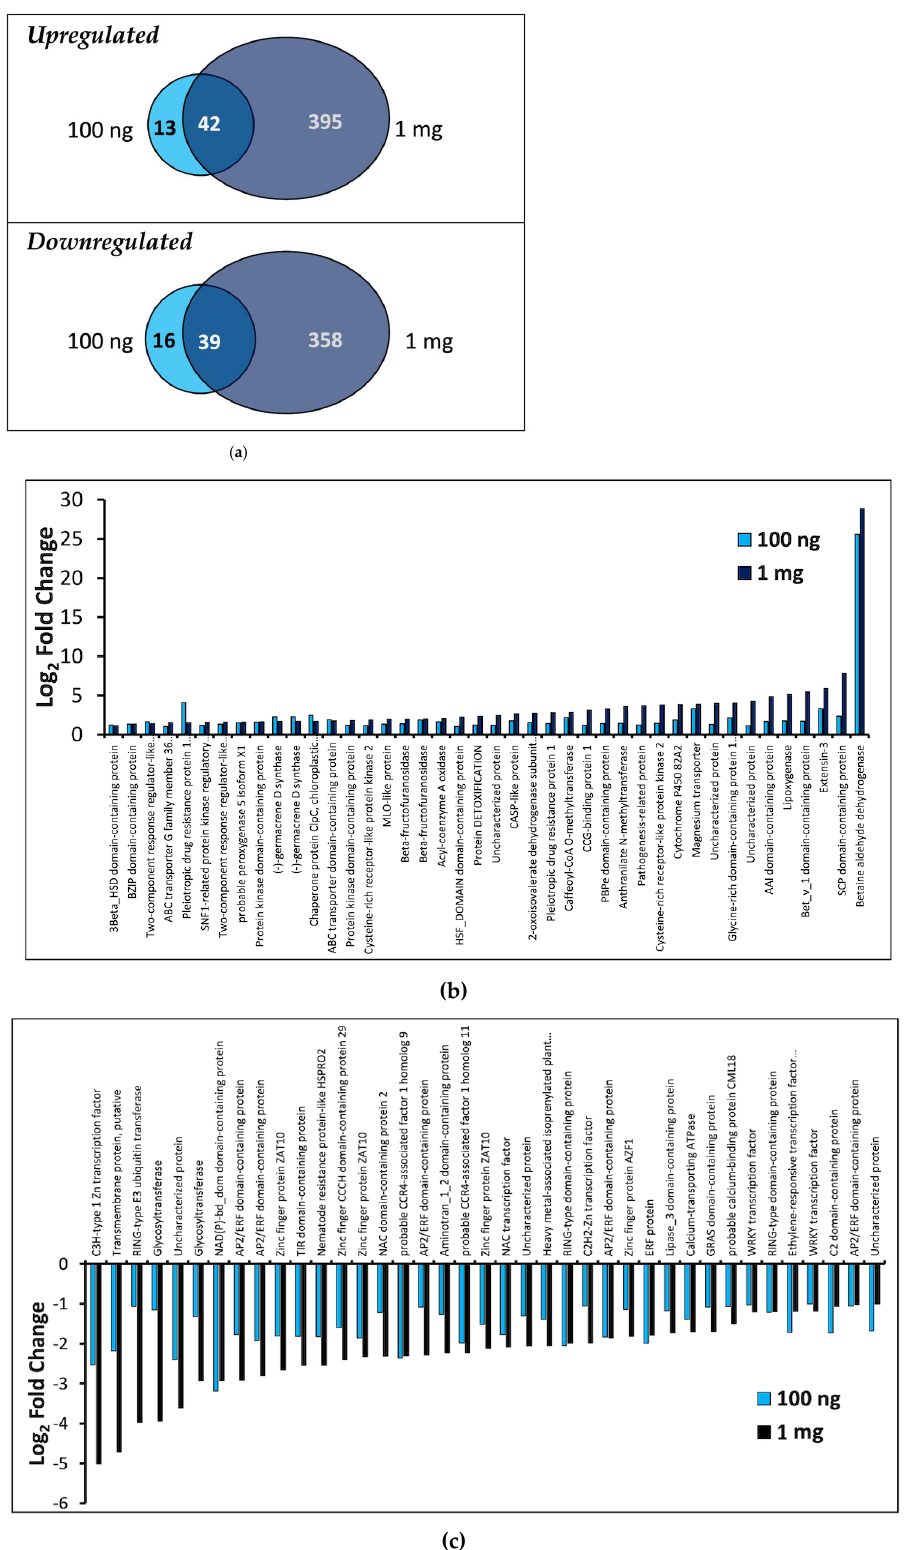
Figure 8. ( a ) Venn diagram showing the number of similar and different upregulated and downreg- ulated genes between DEGs in the 100 ng/L vs. control and 1 mg/L vs. control analysis. Plots of log 2 -fold change against similar DEGs (intersection) in ( b ) upregulated and ( c ) downregulated DEG pro- files in the 100 ng/L and 1 mg/L groups.